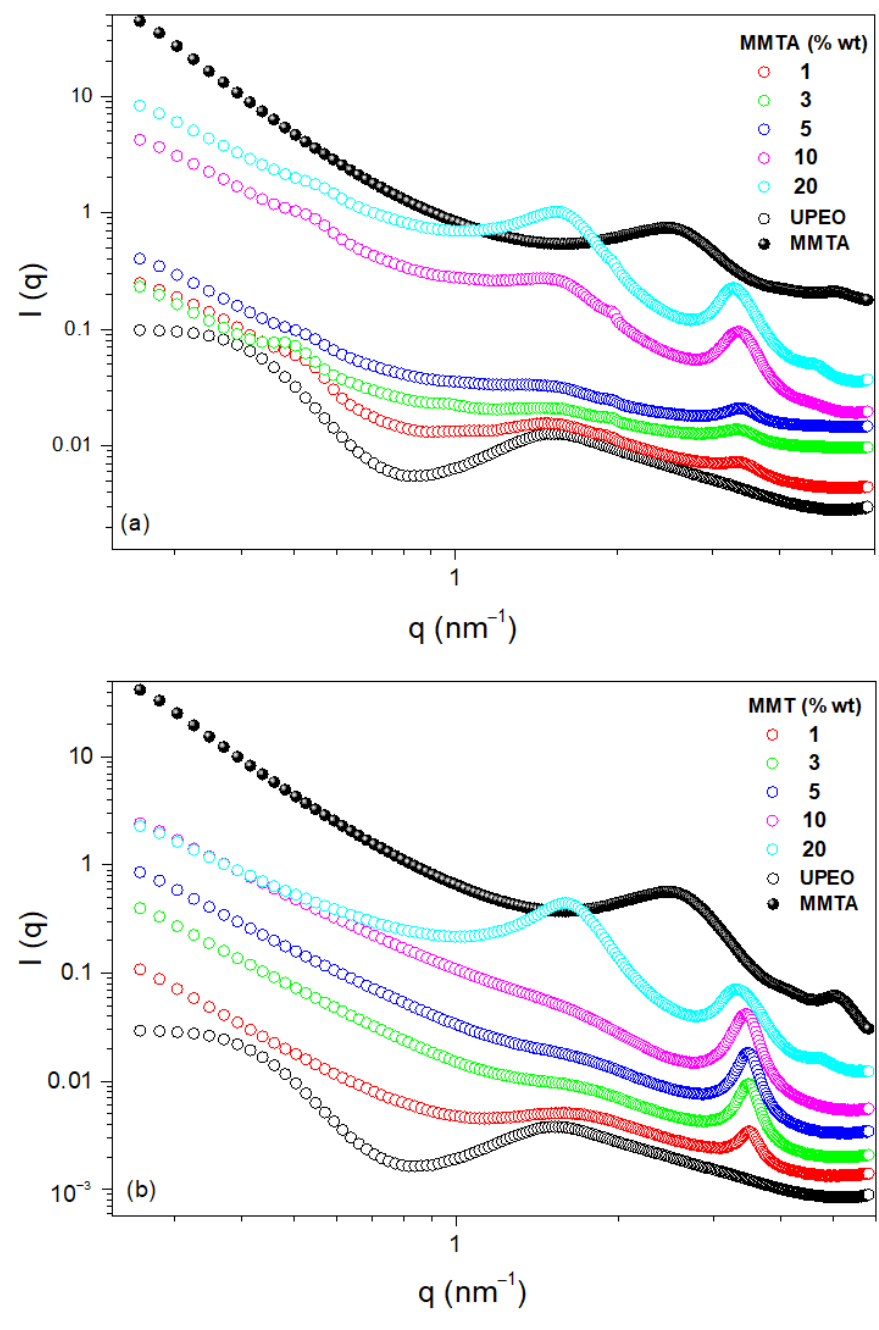
Figure 2. SAXS curves of ( a ) MMTA, hybrid UPEO, and UPEO–MMTA containing different MMTA amounts and ( b ) MMTA, unloaded UPEO, DCF-loaded hybrid UPEO and UPEO–MMTA nanocomposites.